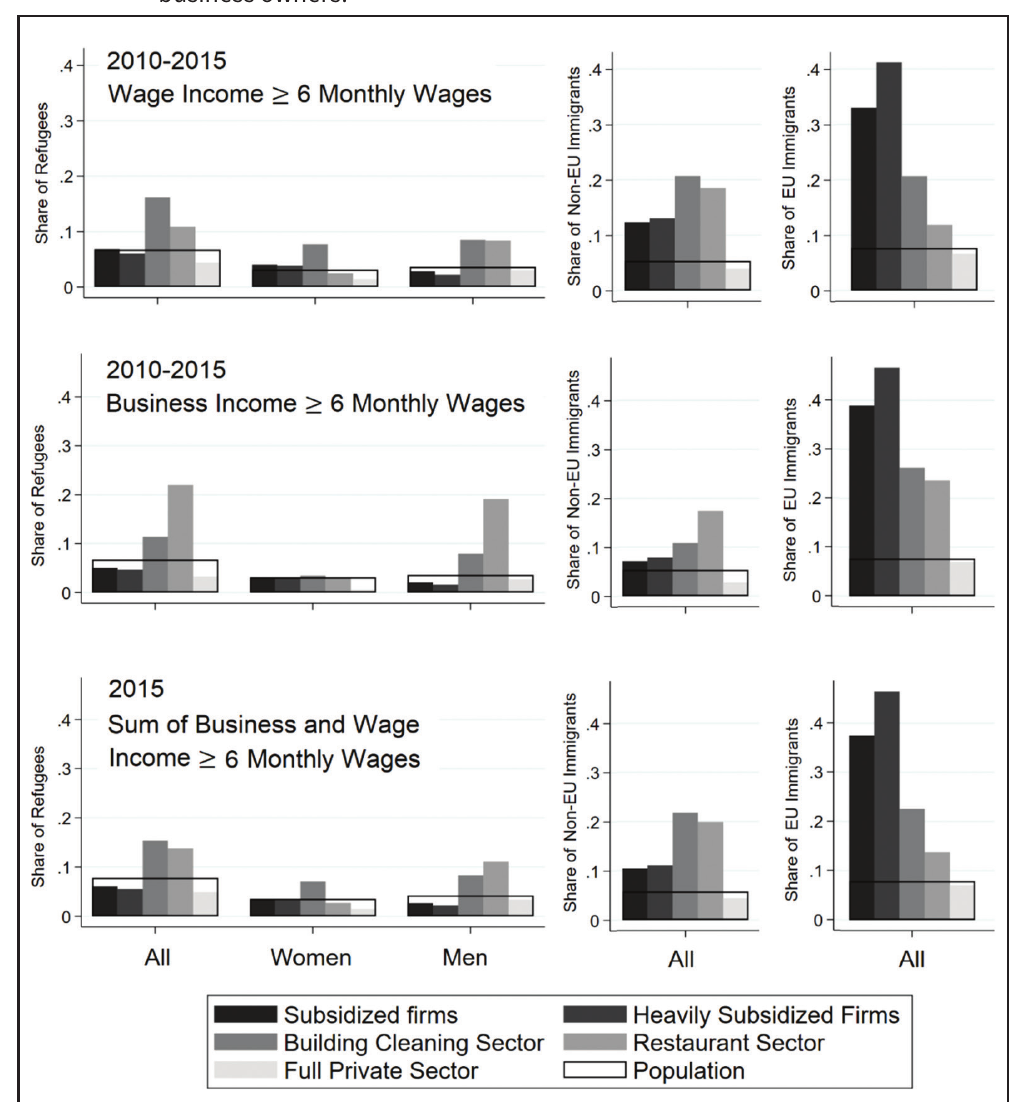
Figure W6 Composition of immigrants in 2015, and among wage earners and small business